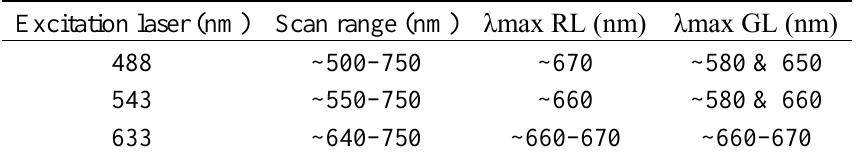
Table 1. Wavelength(s) of maximum absorption after excitation with 488, 543, and 633 nm laser lines. Maximum ranges of fluorescence emission collected at 10.7-nm increments after excitation of GL- and RL-grown filaments.